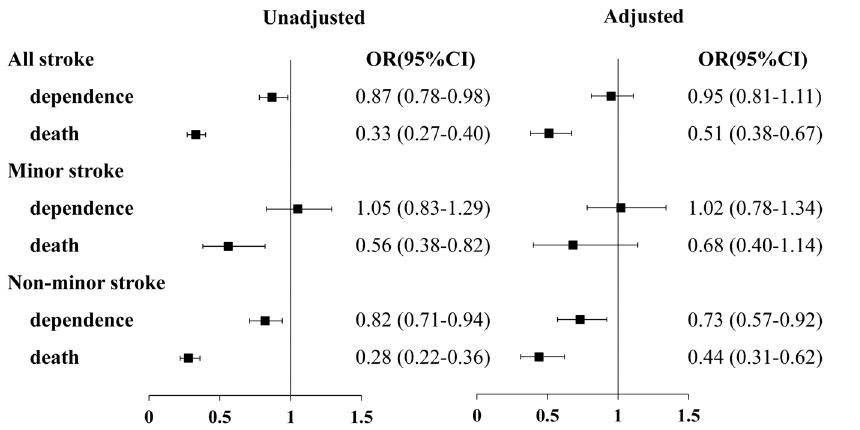
Figure 3. Multivariate analyses of functional outcomes at 3 months for all patients and patients stratified by severity of stroke.